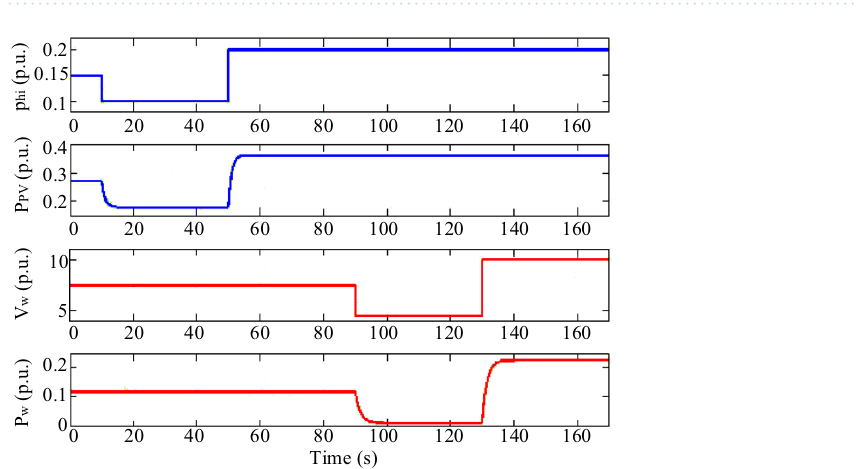
Figure 14. Scenario 1- Microgrid frequency response to step load perturbation for ( a ) normal state, ( b ) with + 30% uncertainty, ( c ) with -30% uncertainty.